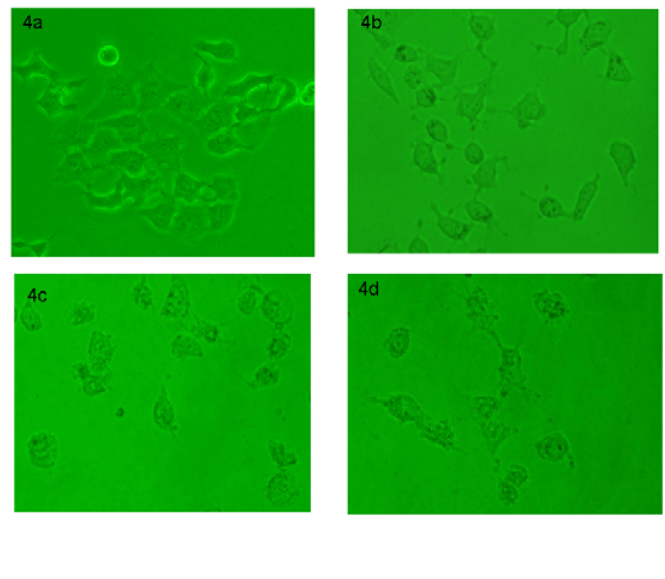
Figure 4. Morphology image of the HepG2 liver cancer cells treated with the control and compound 9 (2.5-20 µM) for 24 h. (4a) the cells treated with DMSO 0.1% (v/v) as a vehicle control; (4b) 2.5 µM; (4c) 10 µM; and (4d) 20